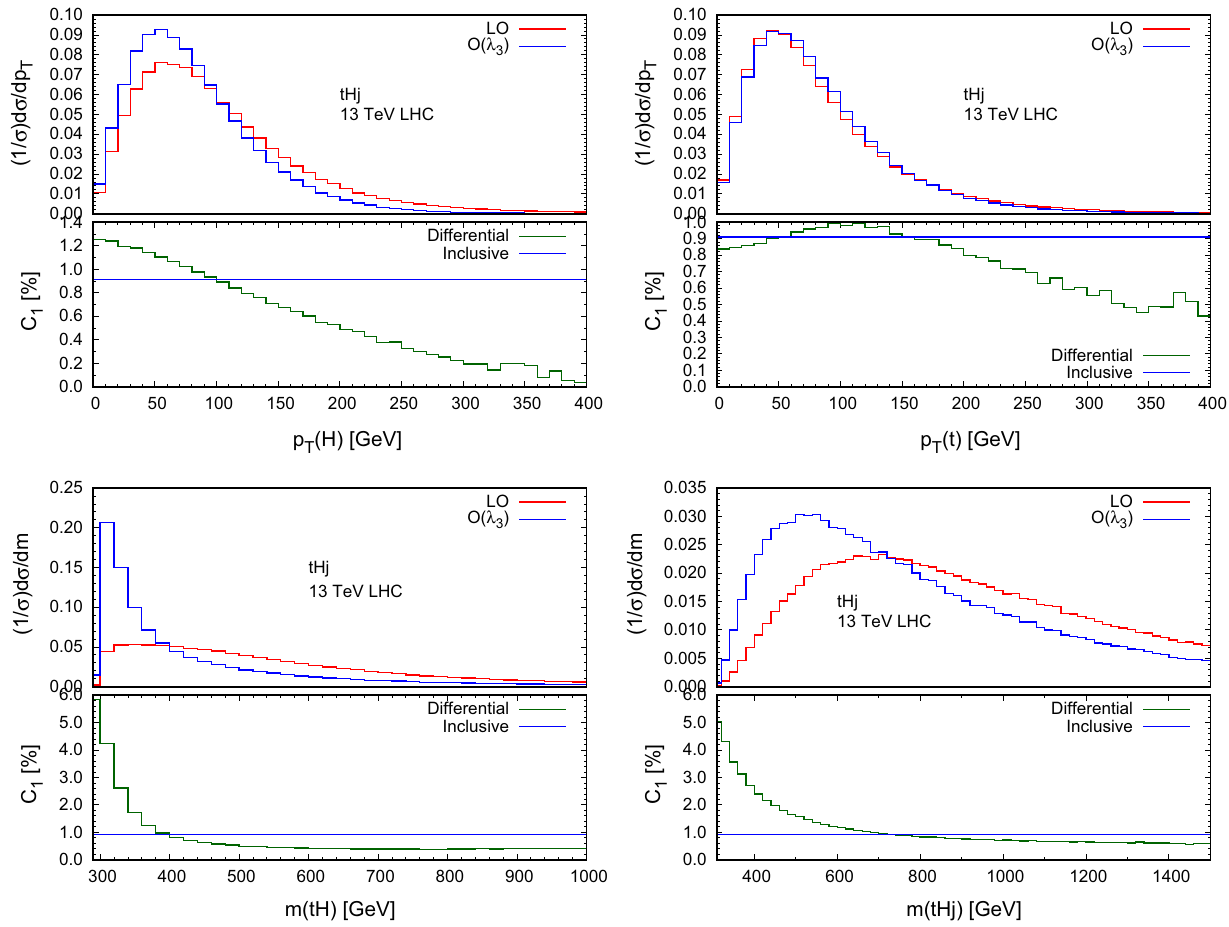
Fig. 6 Effect of O (λ 3 ) correction in tHj at 13 TeV LHC. Upper panel: normalized distributions at LO (red) and at O (λ 3 ) (blue). Lower panel: C 1 at the differential (green) and inclusive (blue) level